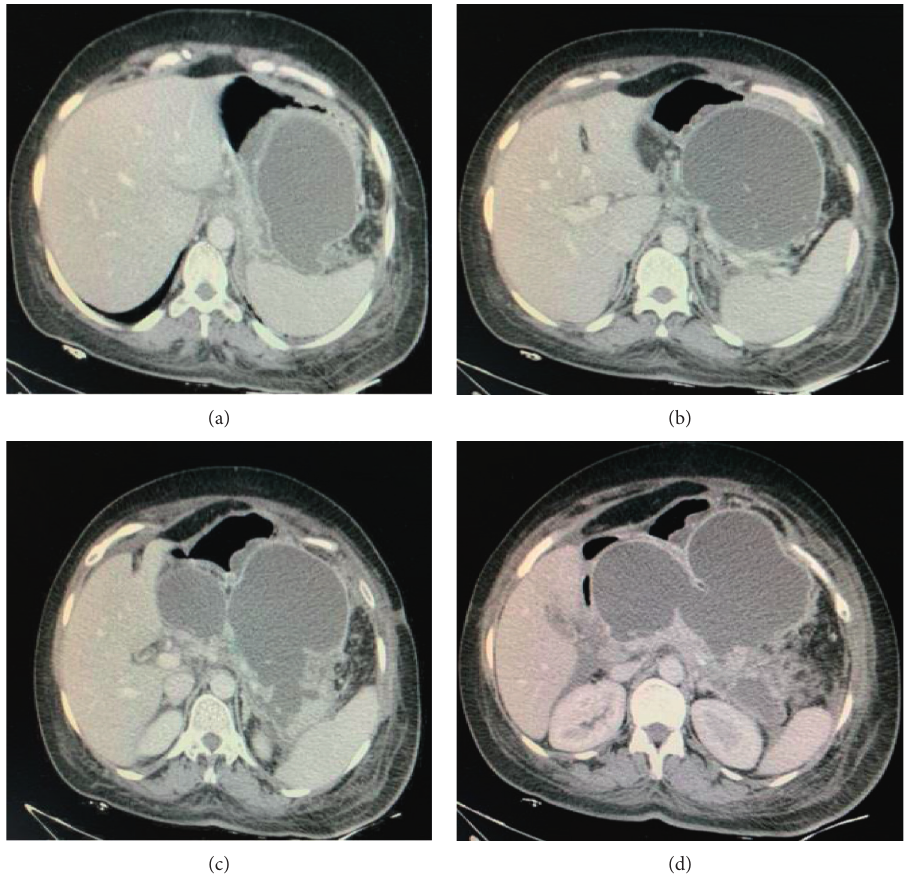
Figure 5: Contrast-enhanced CT scan of the abdomen—huge multiseptated pseudocyst occupying the body and tail of the pancreas.